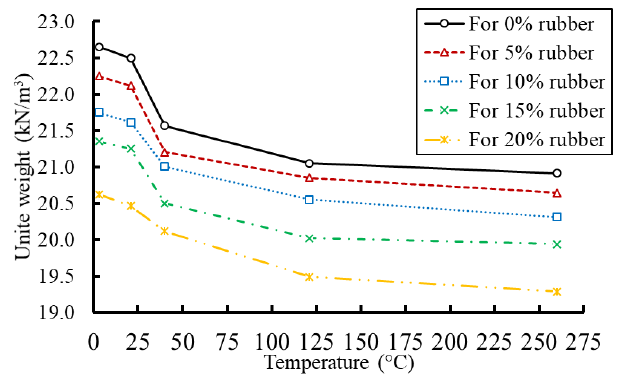
Figure 8. The unit weight of concrete with CR and exposed to temperature.